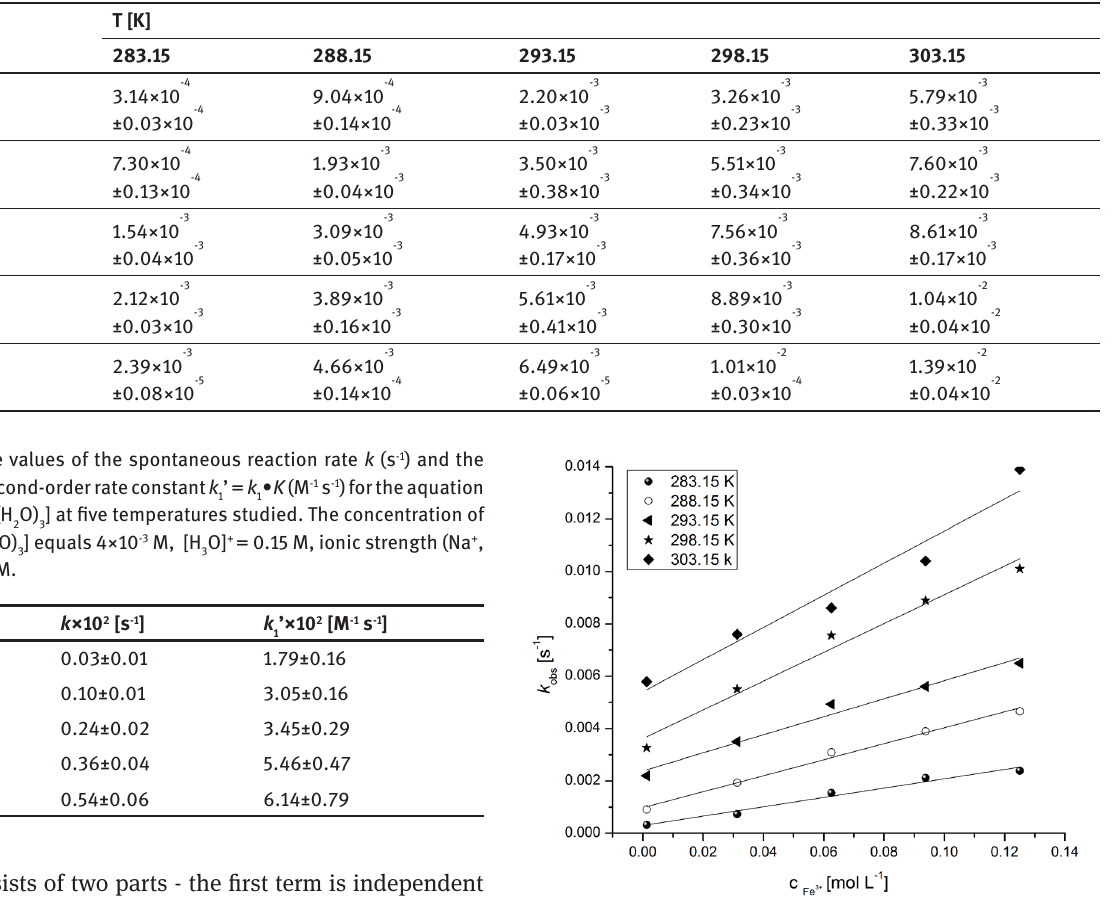
(s -1 ) obs O) ] = 4×10 -3 M, [H O] + = const = 0.15 M, ionic strength 2 3 3